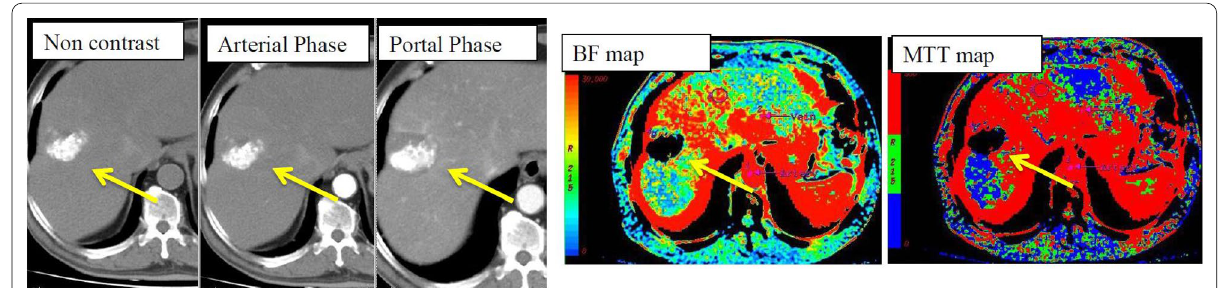
Fig. 2 69-year-old male patient with liver cirrhosis and right hepatic lobe segment VIII HCC underwent chemoembolization on June 2019. Follow-up post-intervention triphasic CT was done on September 2019 and revealed dense injected chemotherapy material “lipidol” showing no evidence of pathological enhancement. CTP functional maps showed intra lesional BF of 102 mL/100 g/min compared to 187 mL/100 g/min in the hepatic parenchyma. In addition, the mean transit time is almost doubled at the lesion measuring about 6 s